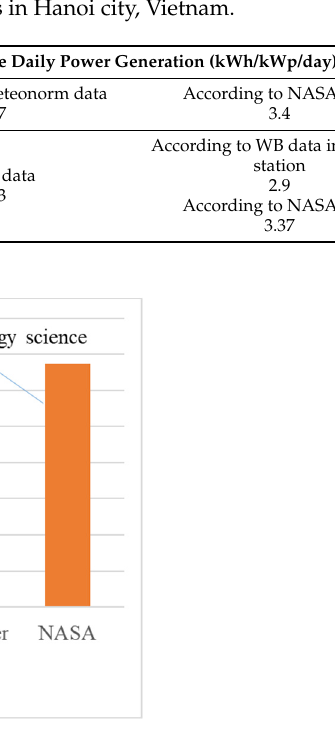
Figure 16. Comparison parameters of solar power stations at Electric Power University and Institute of Energy Science.